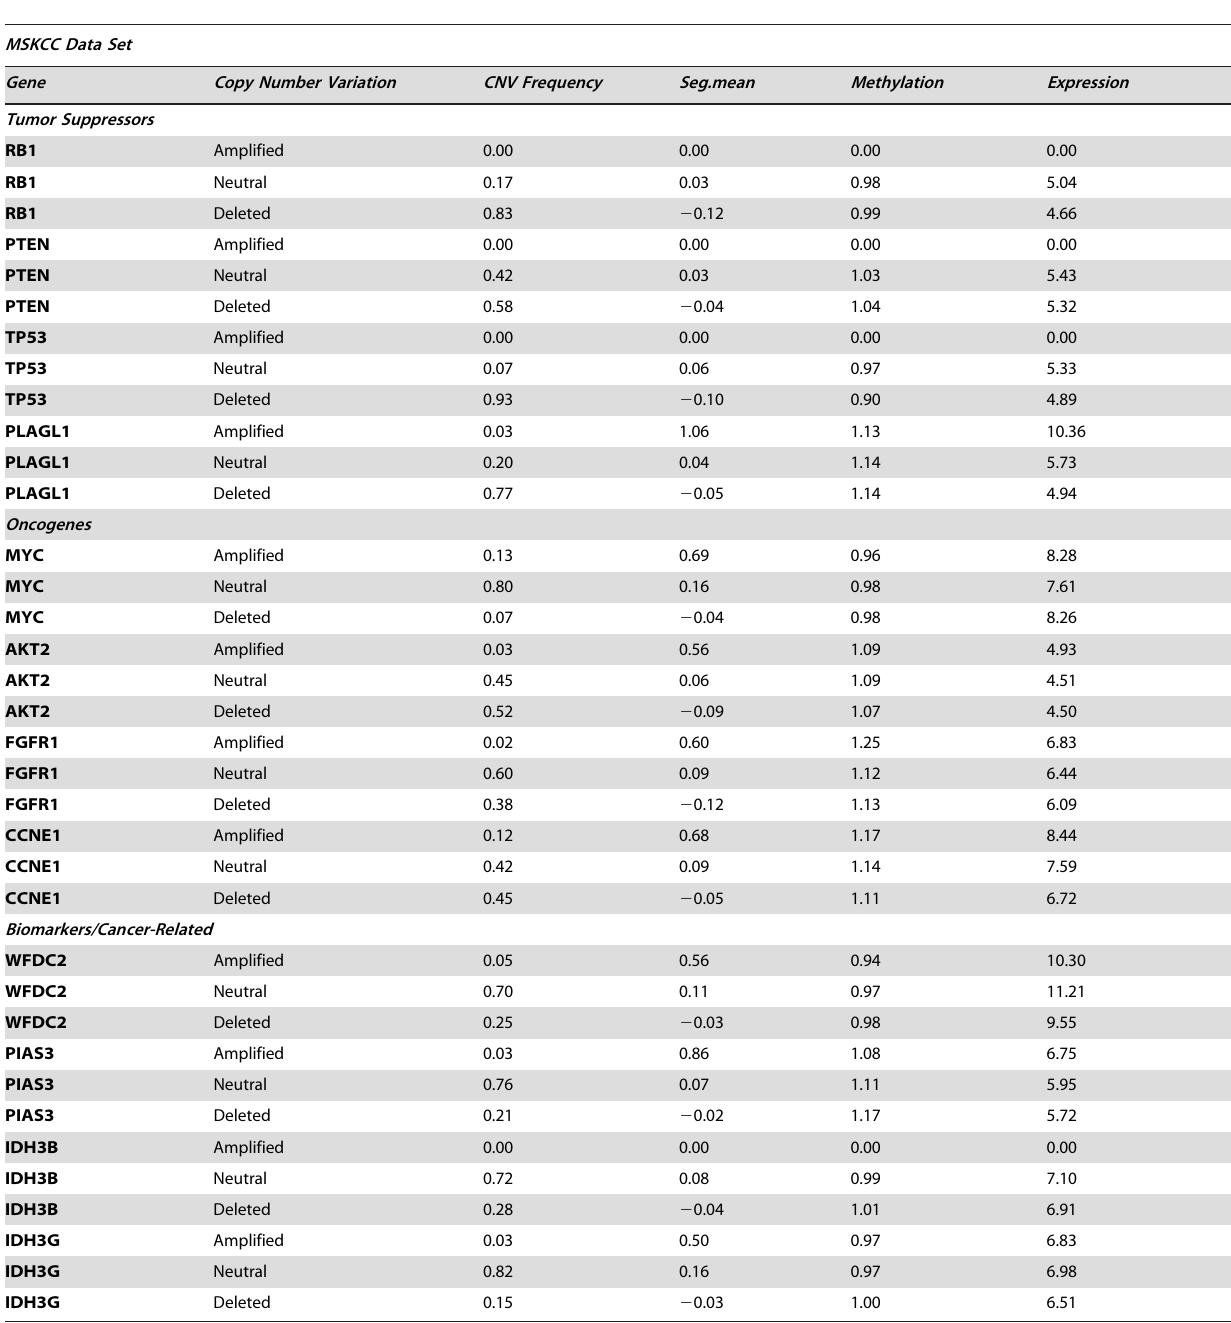
Table 3. Copy number variation derived methylation and expression of tumor suppressors and oncogenes in ovarian cancer * .